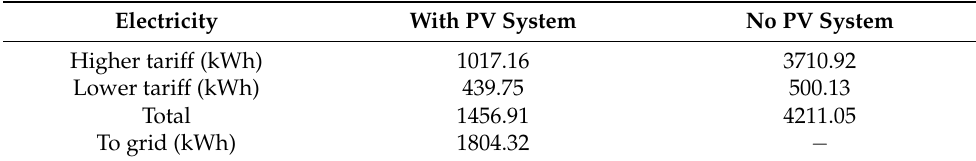
Table 8. Data on energy consumption and production on an annual basis.